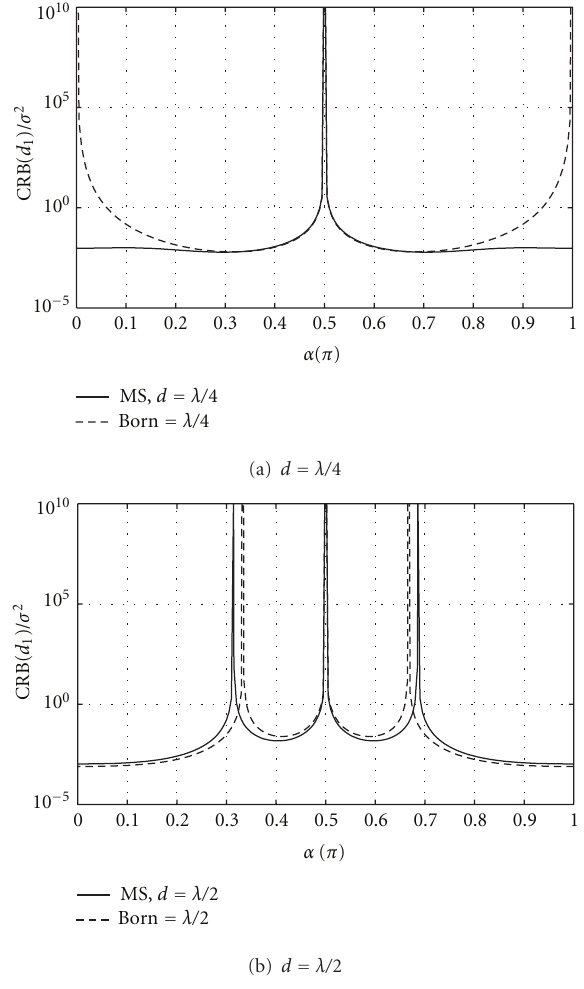
Figure 5: Backscattering CRB( d 1 ) for τ 1 = 1 = τ 2 versus the incidence angle α (where β = π − α ). Plots are provided for (a) d = λ/ 4 and (b) d = λ/ 2.